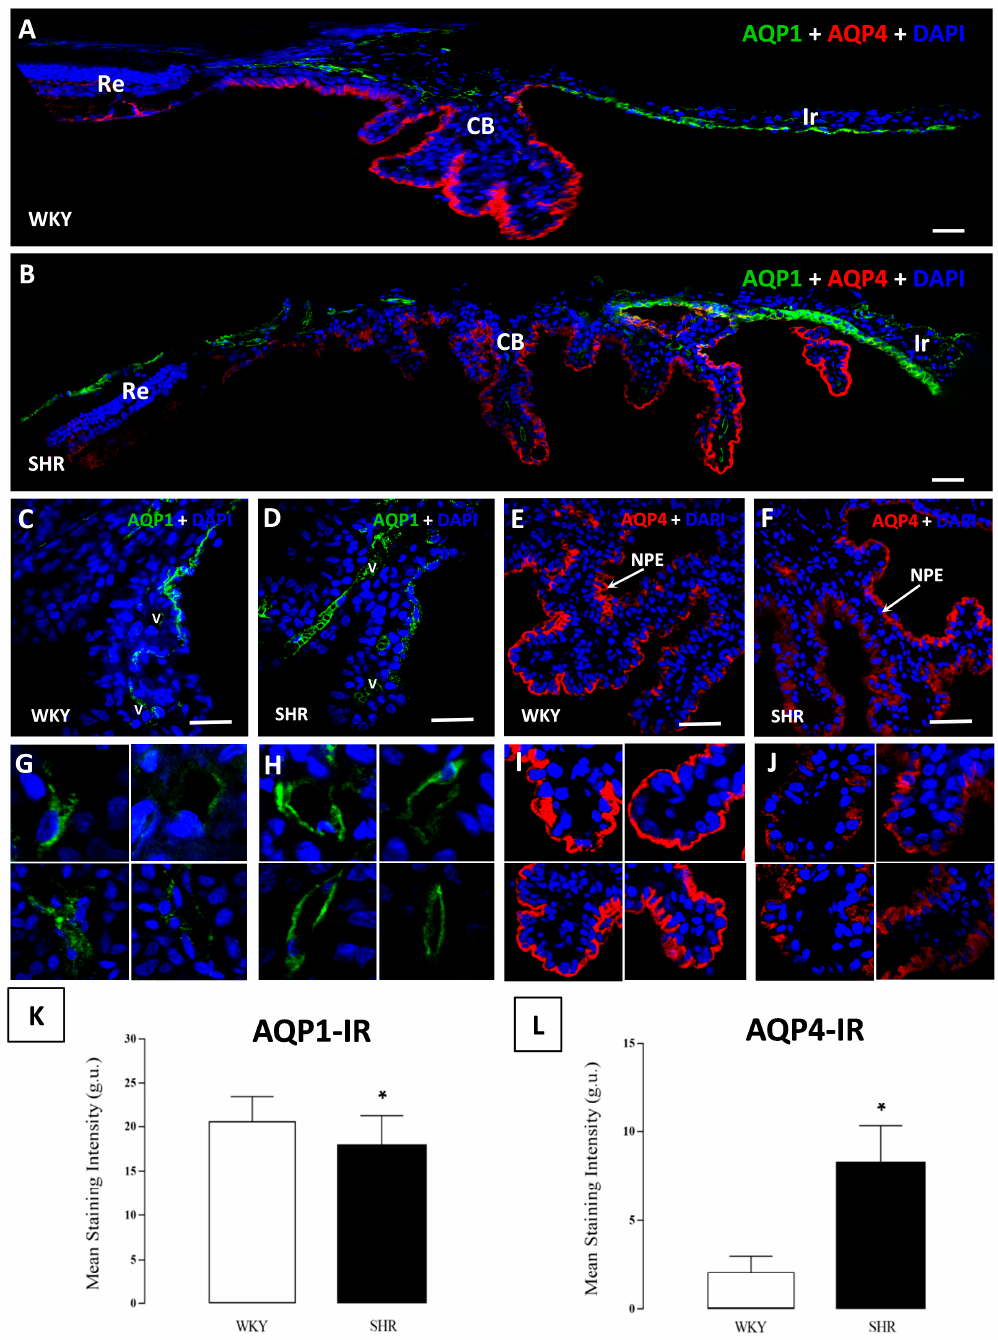
Figure 2. Confocal microscopy images of the expression of AQP1 and AQP4 in the ciliary body of WKY ( A ) rats and SHR ( B ) rats. A reduction of AQP1 was observed in the anterior part of the NPE of the CB in SHR when compared to WKY ( C , D ), while in the blood vessels of the CB, an increase of AQP1 was observed in the SHR ( G , H ) rats. AQP4 was located in the NPE in the basal membrane ( A , B ), with the expression being higher in WKY than in SHR ( E , F ). An increase of CB immunofluorescence with AQP4 is shown in ( I , J ). At the bottom, values of stain intensities in relative units (r.u.) for AQP1 ( K ) and AQP4 ( L ) are represented as the means ± SD ( n = ten animals per group) * p < 0.05 WKY vs. SHR rats. Ir: iris; CB: ciliary body; Re: retina; NPE: non-pigmented epithelium. Scale bars 40 µ m.